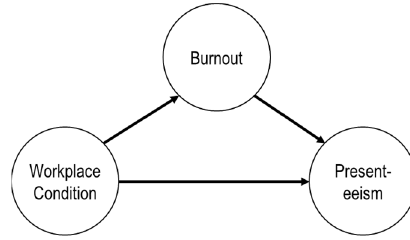
Figure 1. The research model.